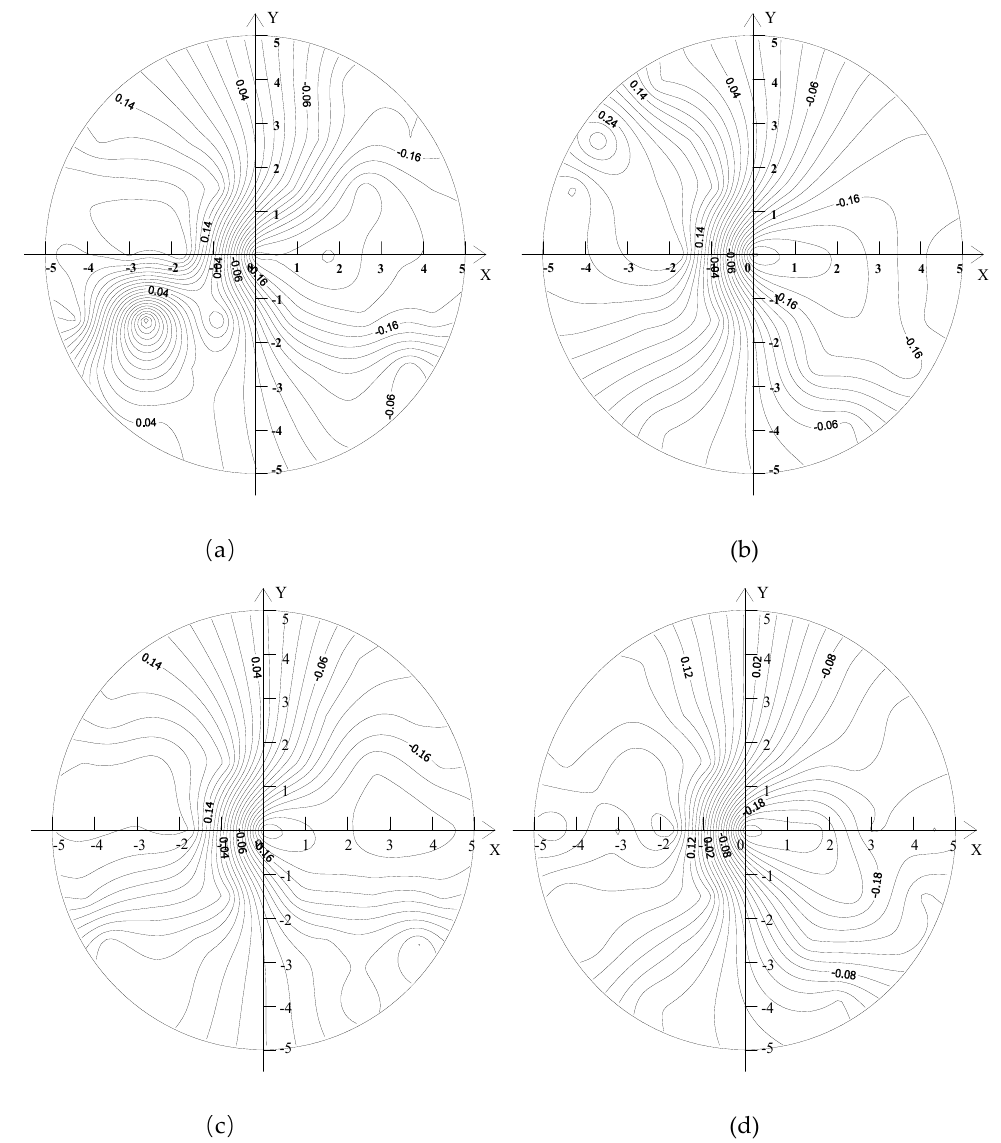
Figure 7. Radial velocity distributions of the upstream sections of capsules: ( a ) L / d = 2.5, Z = 3m; ( b ) L / d = 2.14, Z = 3m; ( c ) L / d = 2.5, Z = 0.1m; and ( d ) L / d = 2.14, Z = 0.1m.